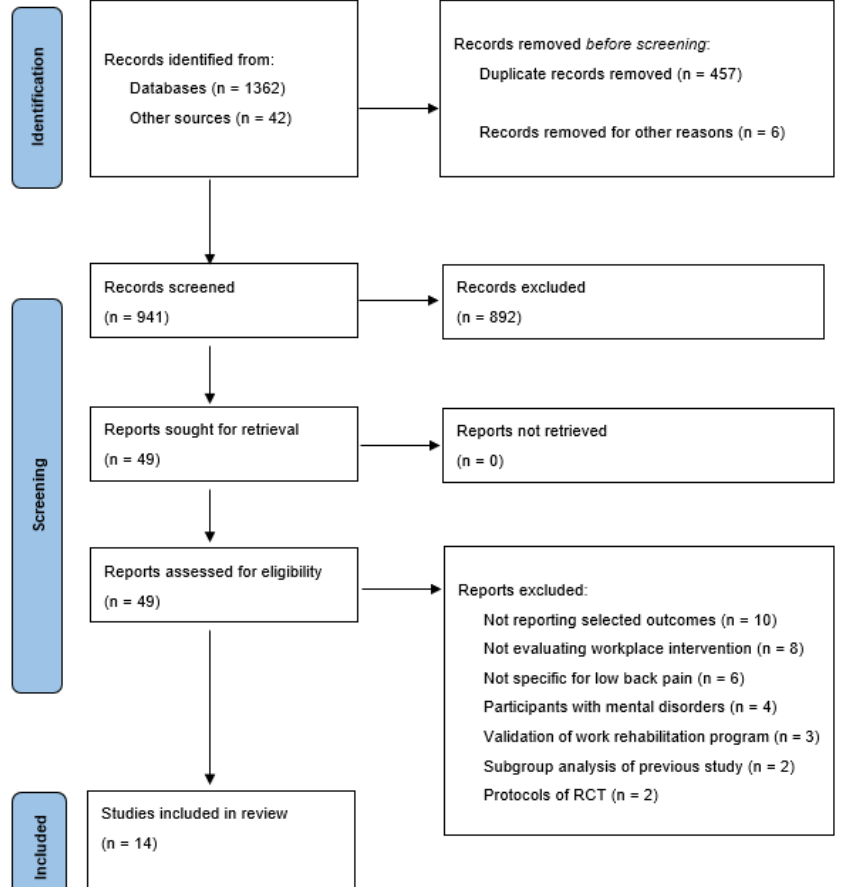
Figure 1. Preferred Reporting Items for Systematic Review and Meta-Analysis (PRISMA) flow dia- gram.